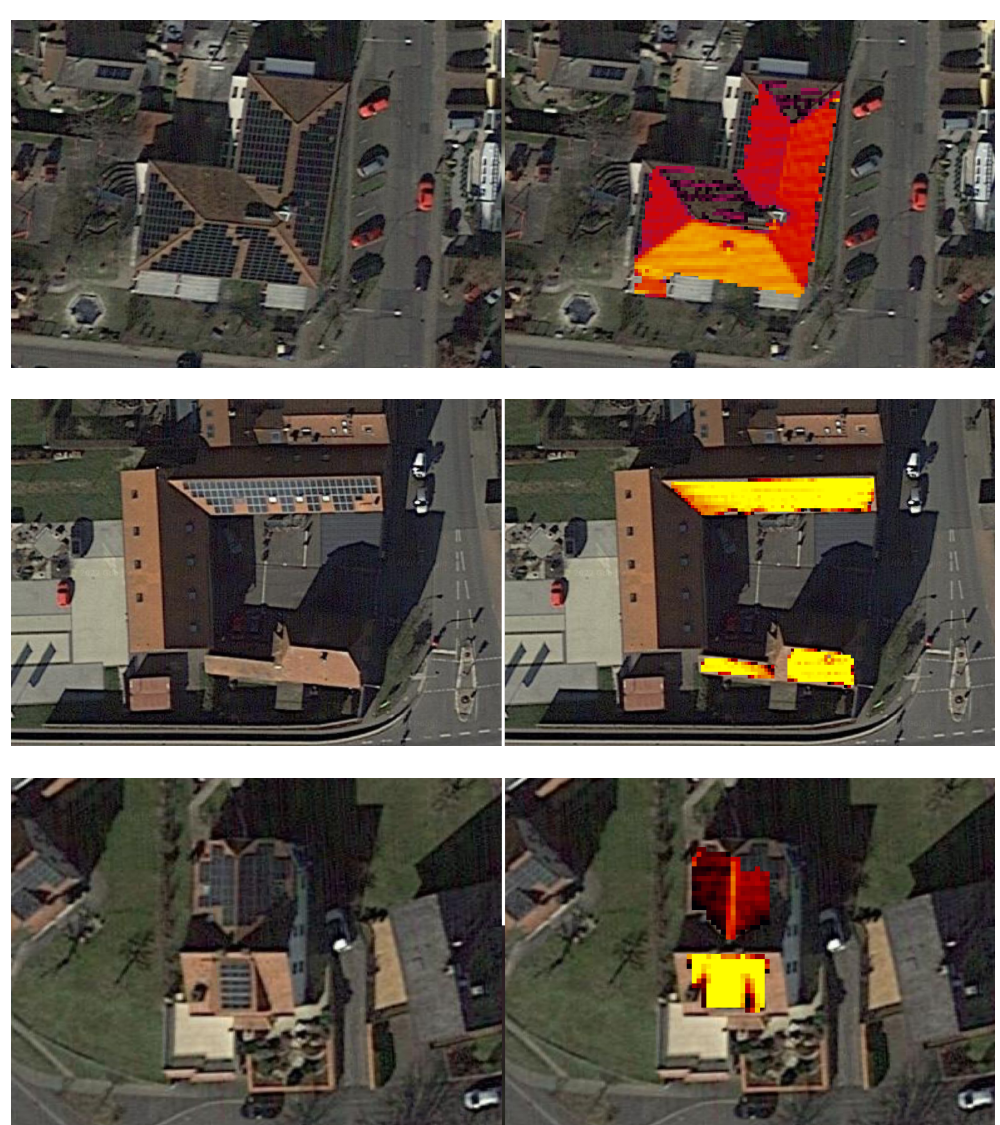
Figure 8. Comparison of existing rooftop PV installations and results proposed by the algorithm. On the ( left ) side, aerial imagery of rooftops with existing PV installations is shown. On the ( right ) side, rooftop segments that have been classified as usable for PV installation by the proposed methodology are marked in colors ranging from yellow to red, representing the amount of incoming yearly global